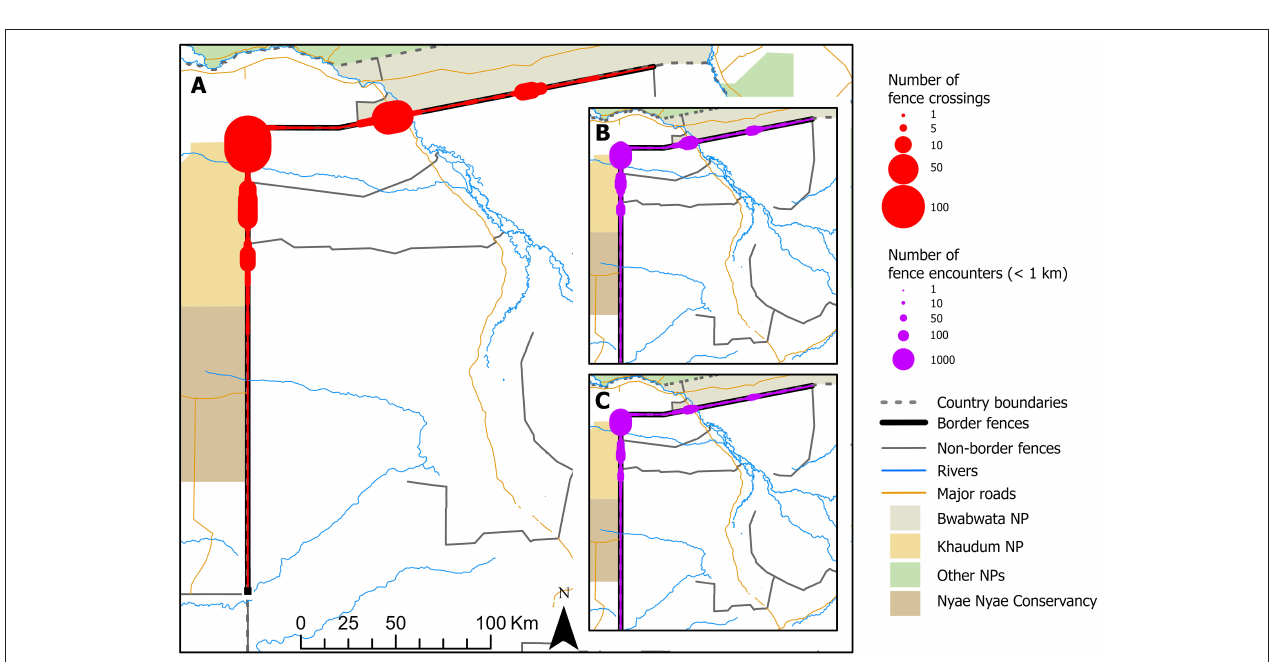
FIGURE 3 | (A) Spatial frequency of Namibia-Botswana border fence crossings by male elephants. Five distinct crossing “hotspots” are visible, with the highest number of 1km fence encounters by both females (B) and males (C) also largely occurring in these same areas.